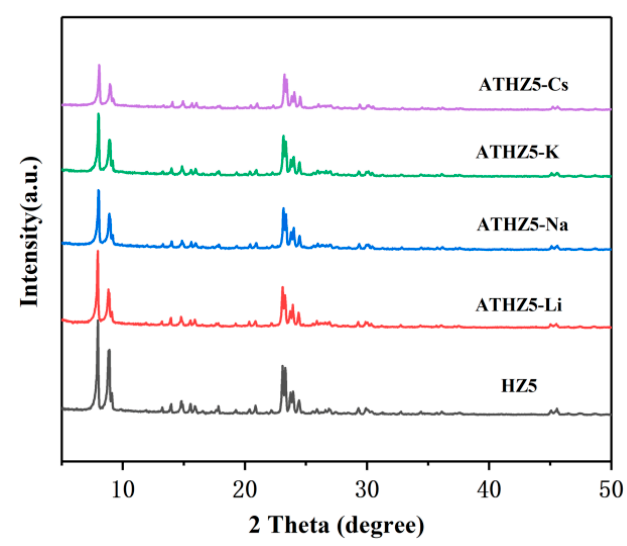
Figure 1. XRD profiles of HZ5 catalyst and modified catalysts. The modified catalysts were obtained by alkali treatment of LiOH, NaOH, KOH, and CsOH aqueous solutions, respectively. Table 1. Elemental composition and textural properties of HZ5 catalyst and modified catalysts.